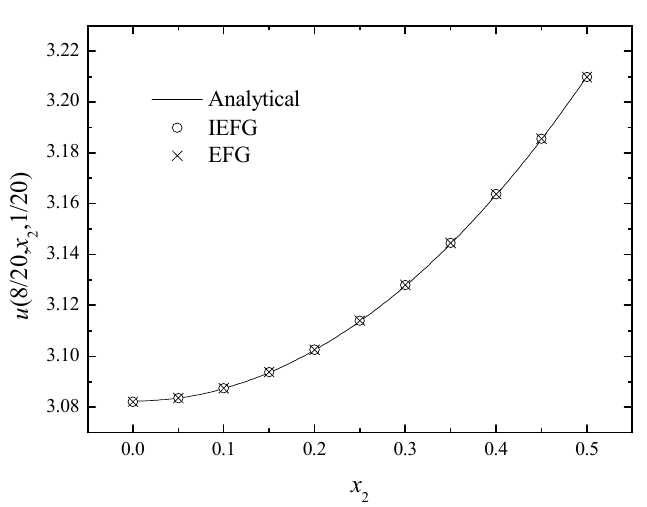
Figure 4. The comparison of numerical and exact solutions along x 1 -axis.